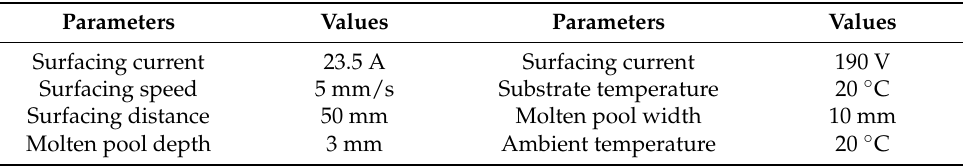
Figure 10. Schematic diagram of the surfacing layer cross section. Both the substrate and welding wire materials are selected from AISI_H13 steel in the material library. The chemical composition of AISI_H13 steel material is shown in Table 2. In the process of surfacing, the fixed base plate is used to fix the X, Y and Z degrees of freedom on both sides of the clamp. At the end of the cooling stage, no restriction is imposed. The outer surface, except the contact surface between the surfacing layer and the substrate, is set as the heat transfer boundary condition, and the initial temperature is set at 20 ◦ C. According to the results of experiment, set the simulation process parameters as shown in Table 5. Table 5. Welding simulation process